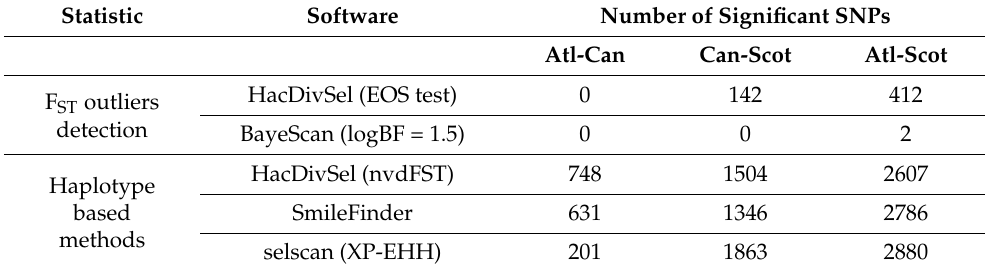
Table 2. Summary of significant SNPs in each comparison between studied populations after the ap- plication of different selection detection methods (Atl-Can: Atlantic–Cantabric; Can-Scot: Cantabric– Scotland; Atl-Scot: